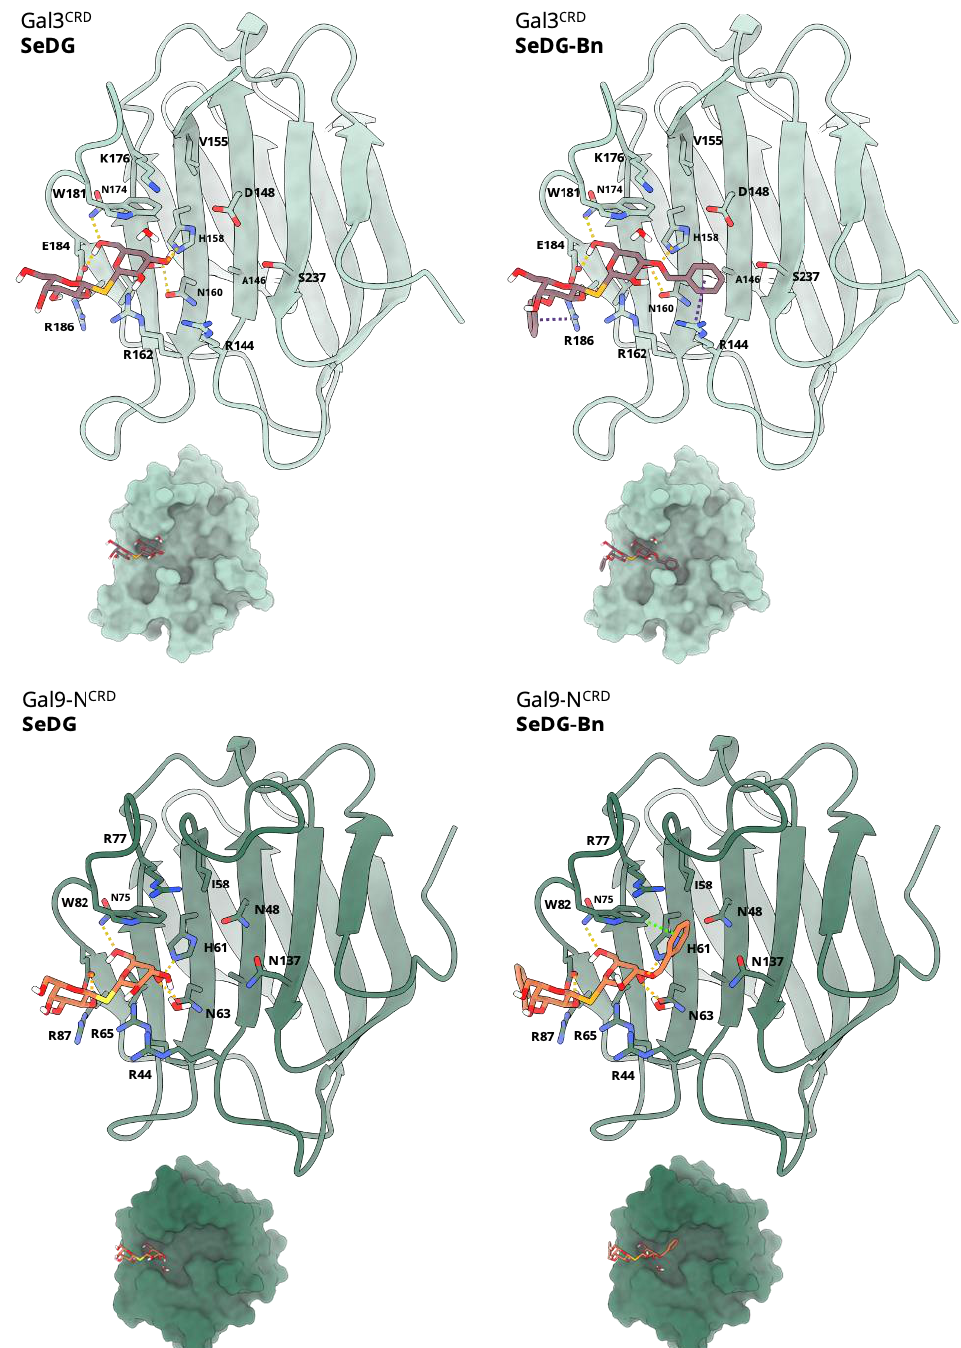
Figure 1. Docked poses of digalactosyl selenide (SeDG) and 3,3’ -O-dibenzyl digalactosyl selenide (SeDG-Bn) to Gal-3 CRD and Gal-9N CRD . Hydrogen bonds between the side chains of the protein residues and the different ligands are depicted in dashed lines, π -cation interactions are depicted in purple dashed lines, and π - π interactions are depicted in green dashed lines.